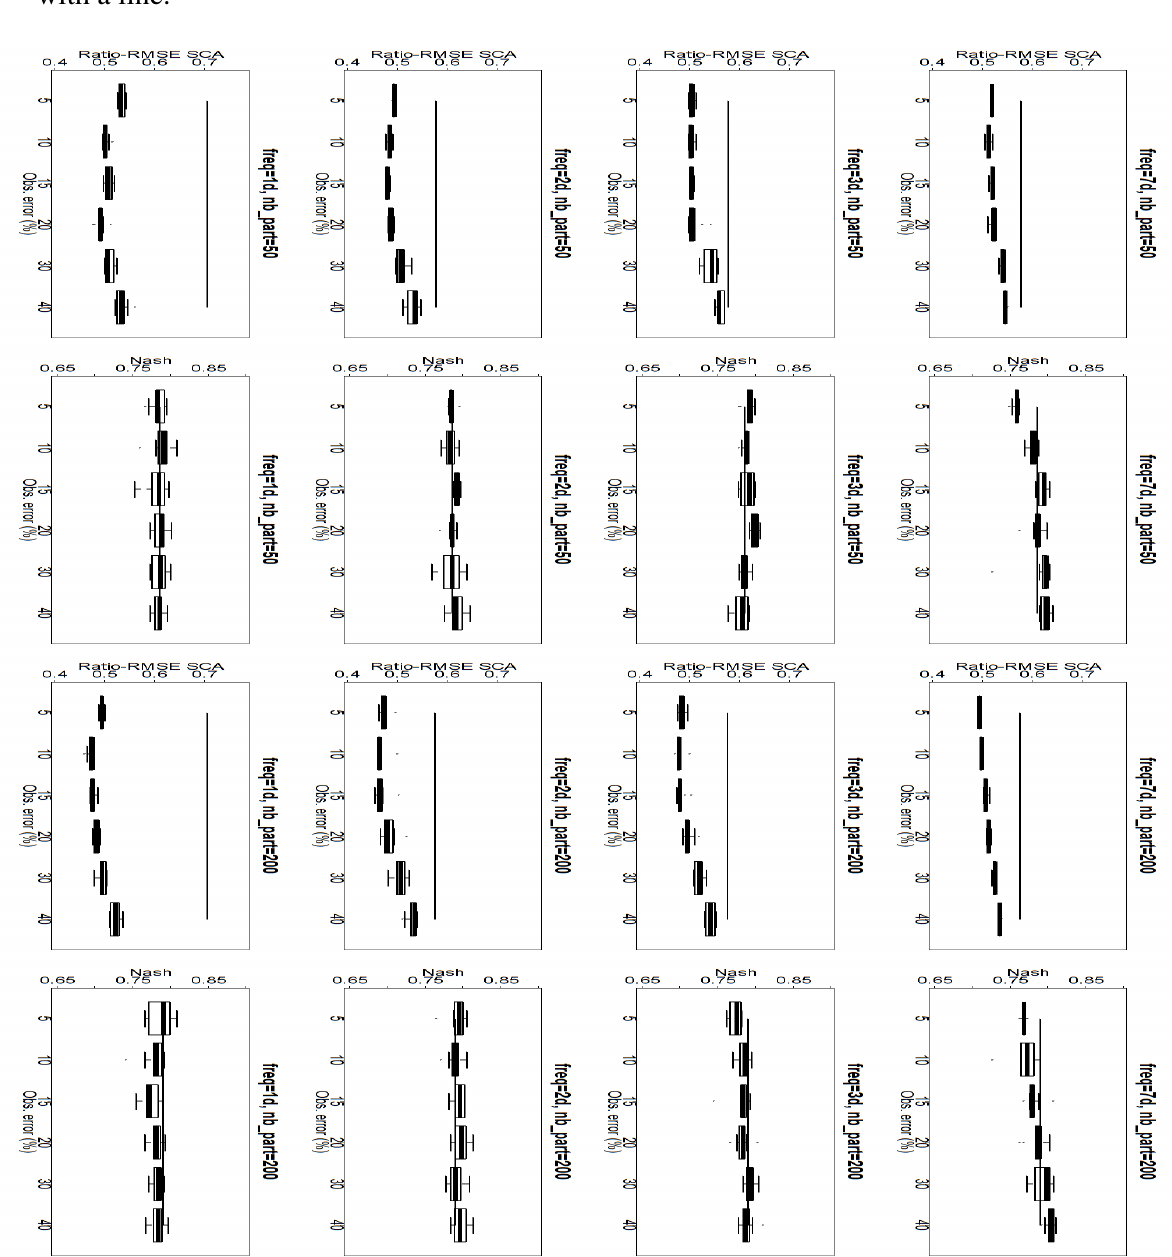
Figure 11. SCA ratio-RMSE and Nash for the real MODIS SCA particle filter experiments on the whole Morava basin. The frequency of assimilation (freq) and the number of particles (nb part) are indicated for every panel on the y-axis. The boxplots are drawn for 10 similar-condition experiments. The corresponding no-assimilation experiment is represented with a